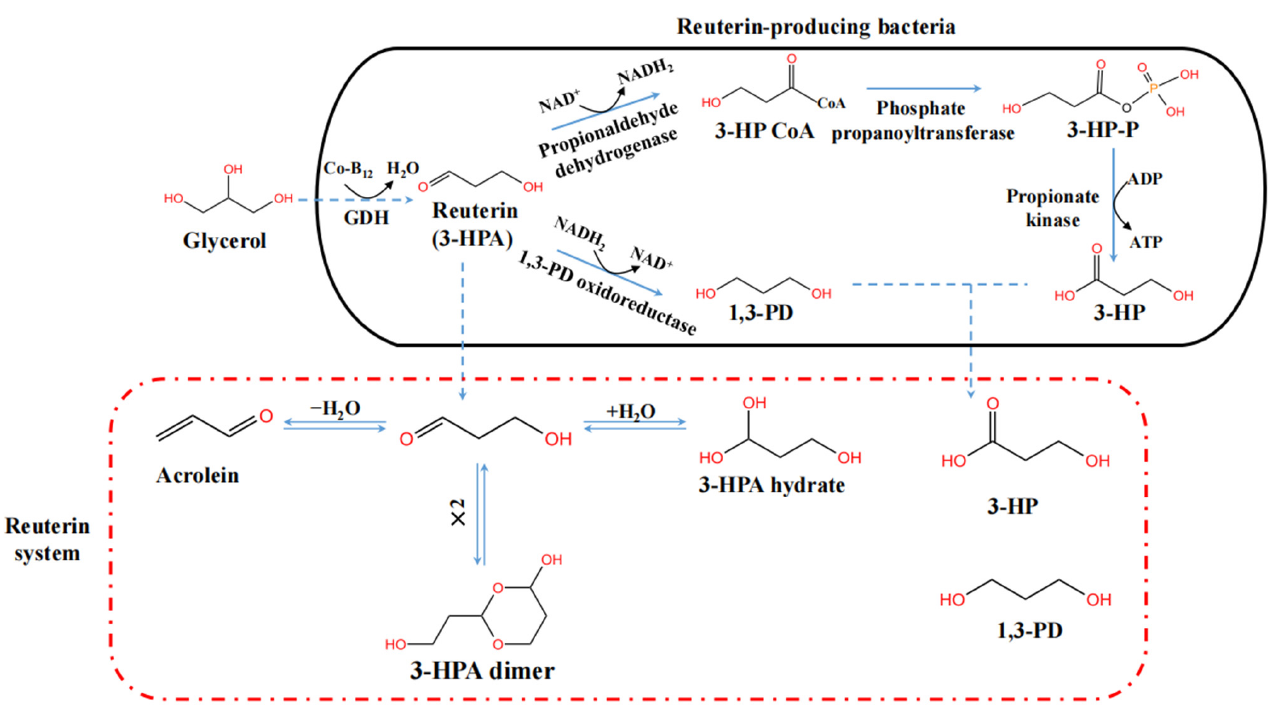
Figure 1. The metabolic pathway of reuterin (3-HPA) and the components of the reuterin system formed by in situ production of 3-HPA in the aqueous solution [12,26,31]. The reuterin system produced by 3-HPA purification does not contain 3-HP and 1,3-PD.